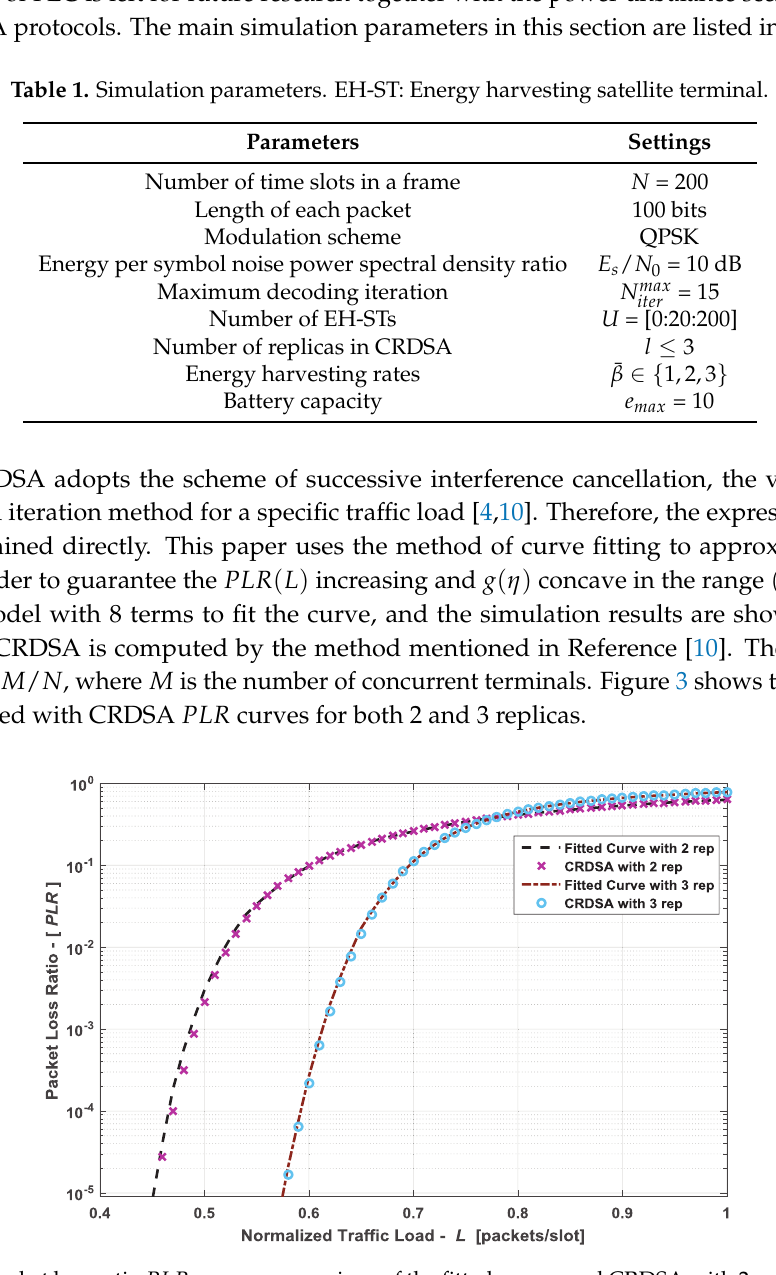
Figure 3. Packet loss ratio PLR curves comparison of the fitted curves and CRDSA with 2 and 3 replicas, number of time slots N = 200, QPSK modulation, E s / N 0 = 10